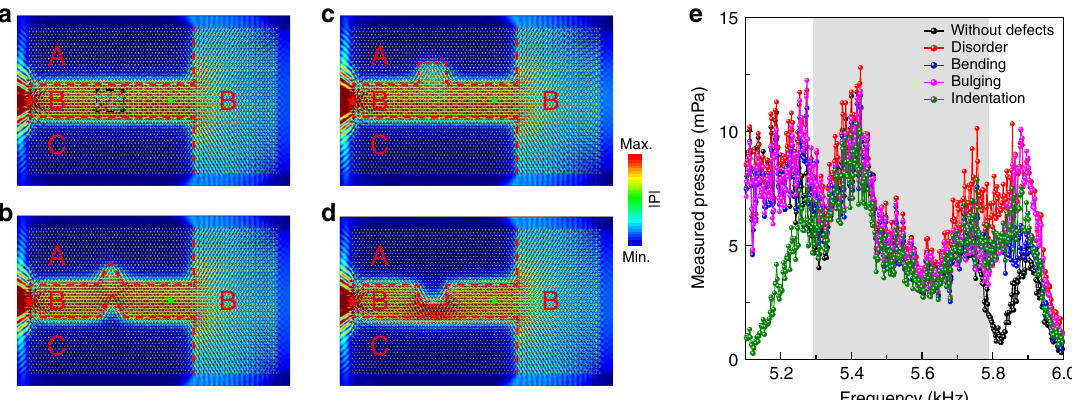
Fig. 4 Robustness of the TVWSs against defects. a – d Simulated acoustic pressure fi eld distributions at 5.55 kHz in the waveguides with four different structural defects: disorder, bending, bulging, and indentation. e Pressures measured at the points indicated by the green dots near the exits of the four waveguides with defects compared with that of the waveguide without any defects. The good consistency in the shadowed region indicates the immunity of the TVWSs against defects.